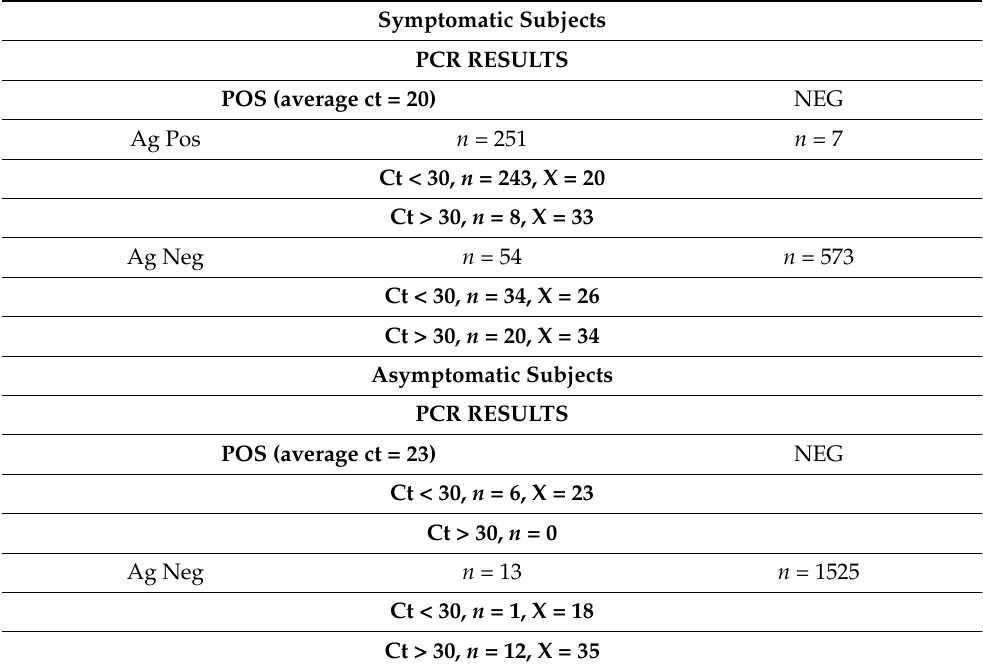
Table 3. Relationship between PCR cycle threshold and rapid antigen test